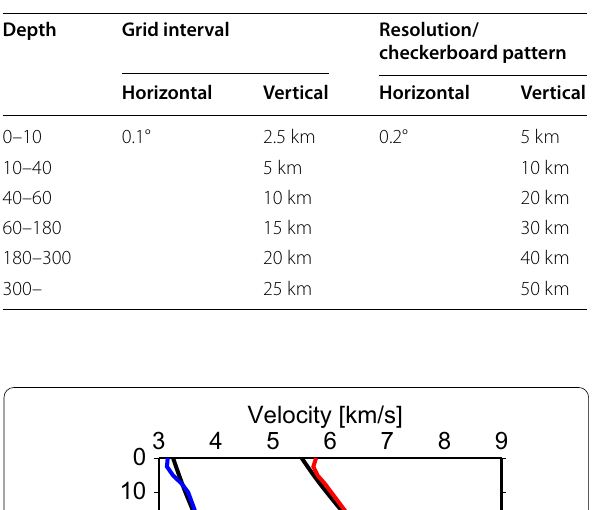
Table 1 Grid interval and resolution size